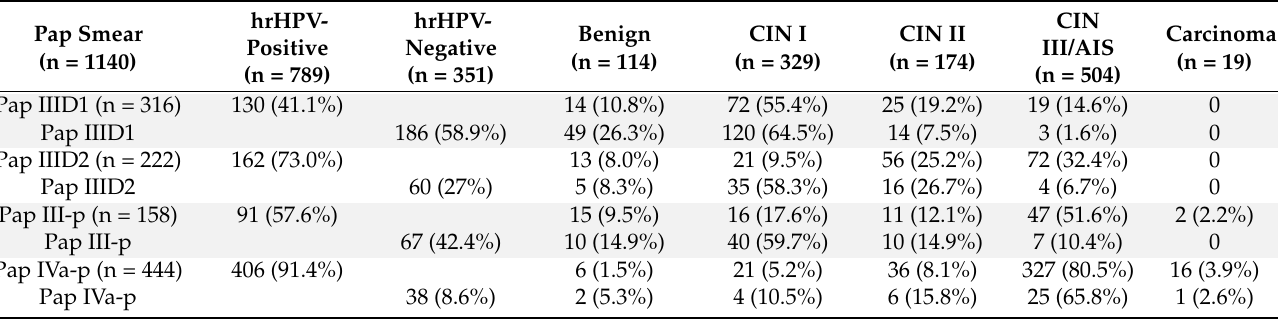
Table 4. Results for Pap IIID1, IIID2, III-p, and IVa-p in comparison the histologic results in women aged >